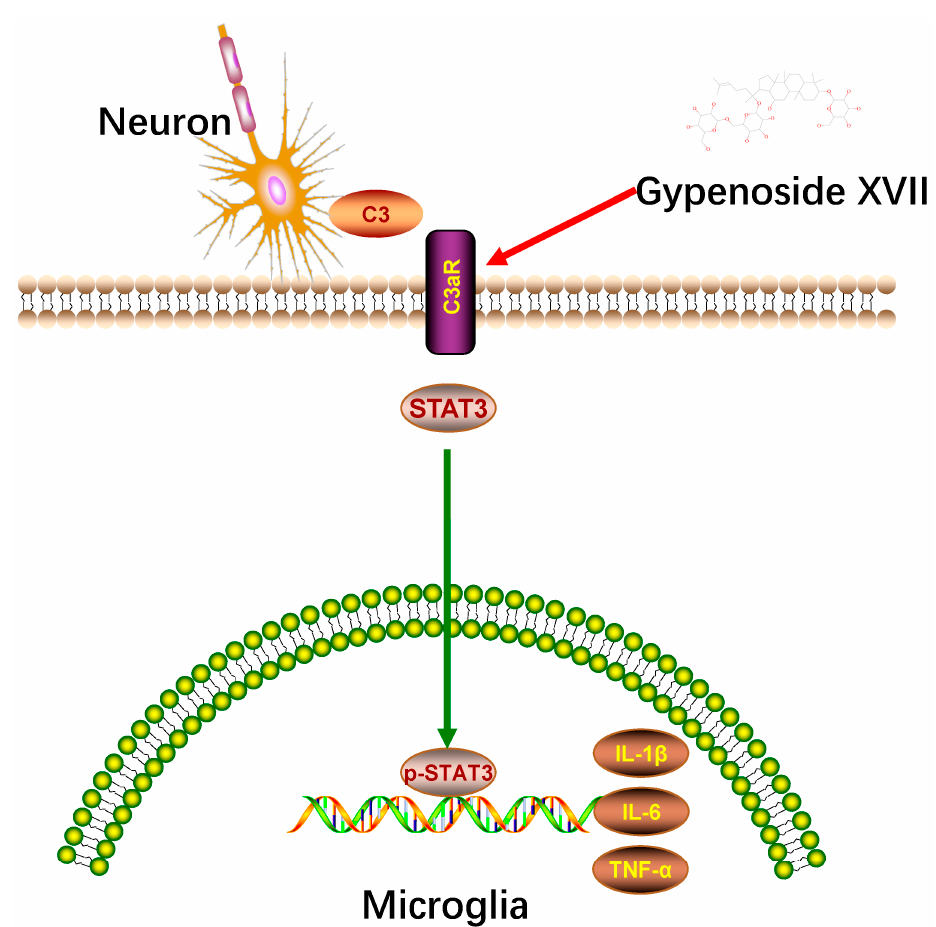
Figure 6. Schematic diagram of the antidepressant-like Gypenoside XVII in CUMS-induced mice. Chronic stress activates microglia and enhances C3 release. C3 targets neuron and recruit microglia to eliminate targeted synapses. Meanwhile, C3 binds with C3aR to activate STAT3. Subsequently, STAT3 induces the activation of the pro-inflammatory cytokine to aggravate the inflammatory